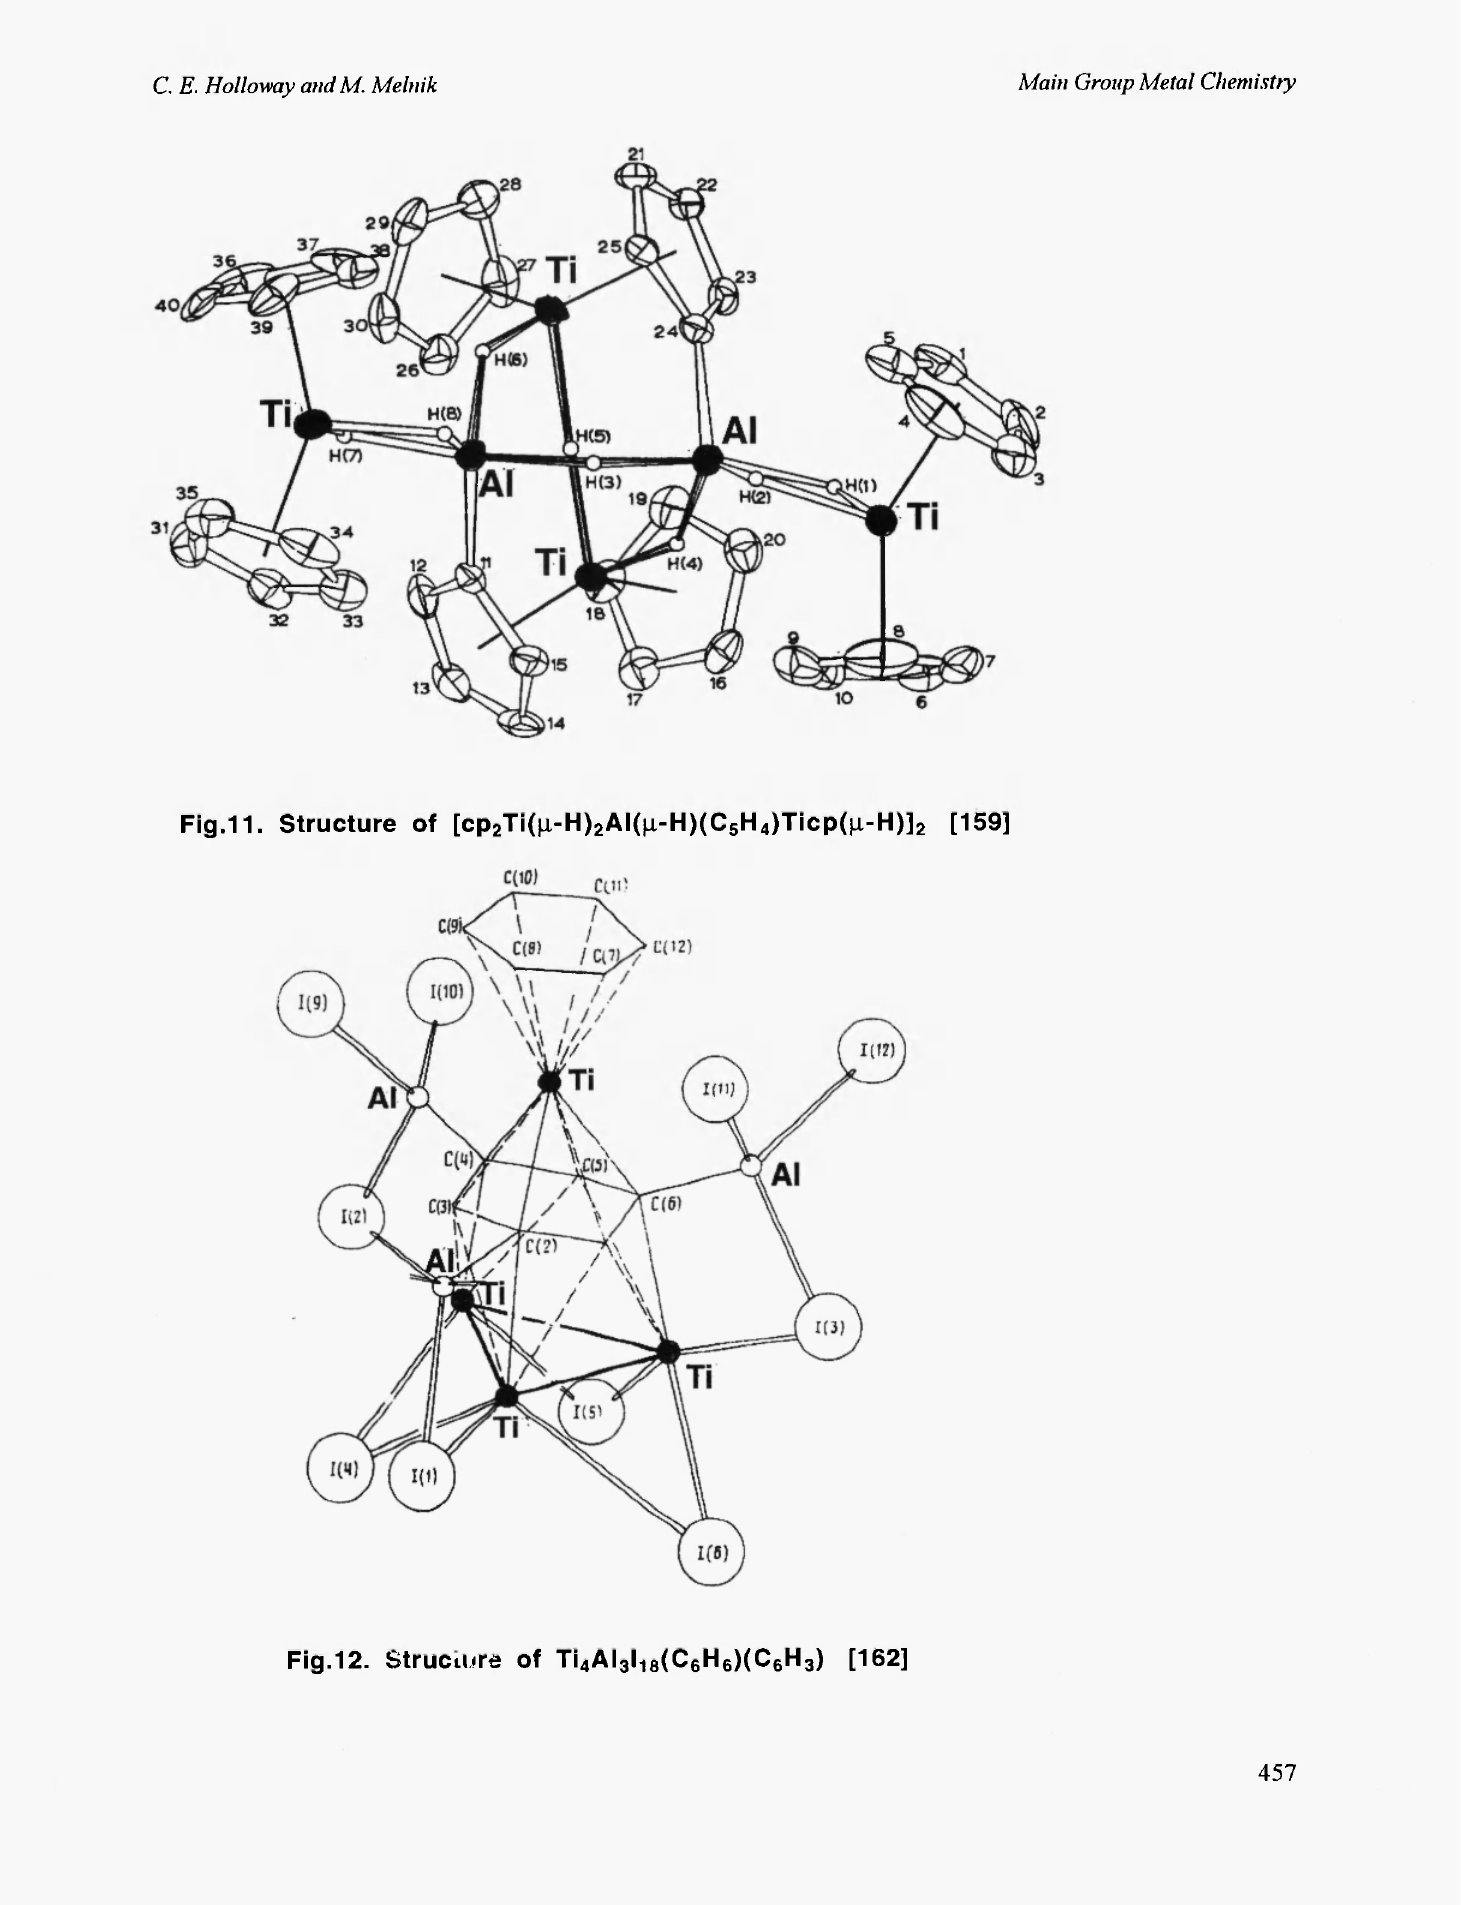
Fig.12. Structure of Ti